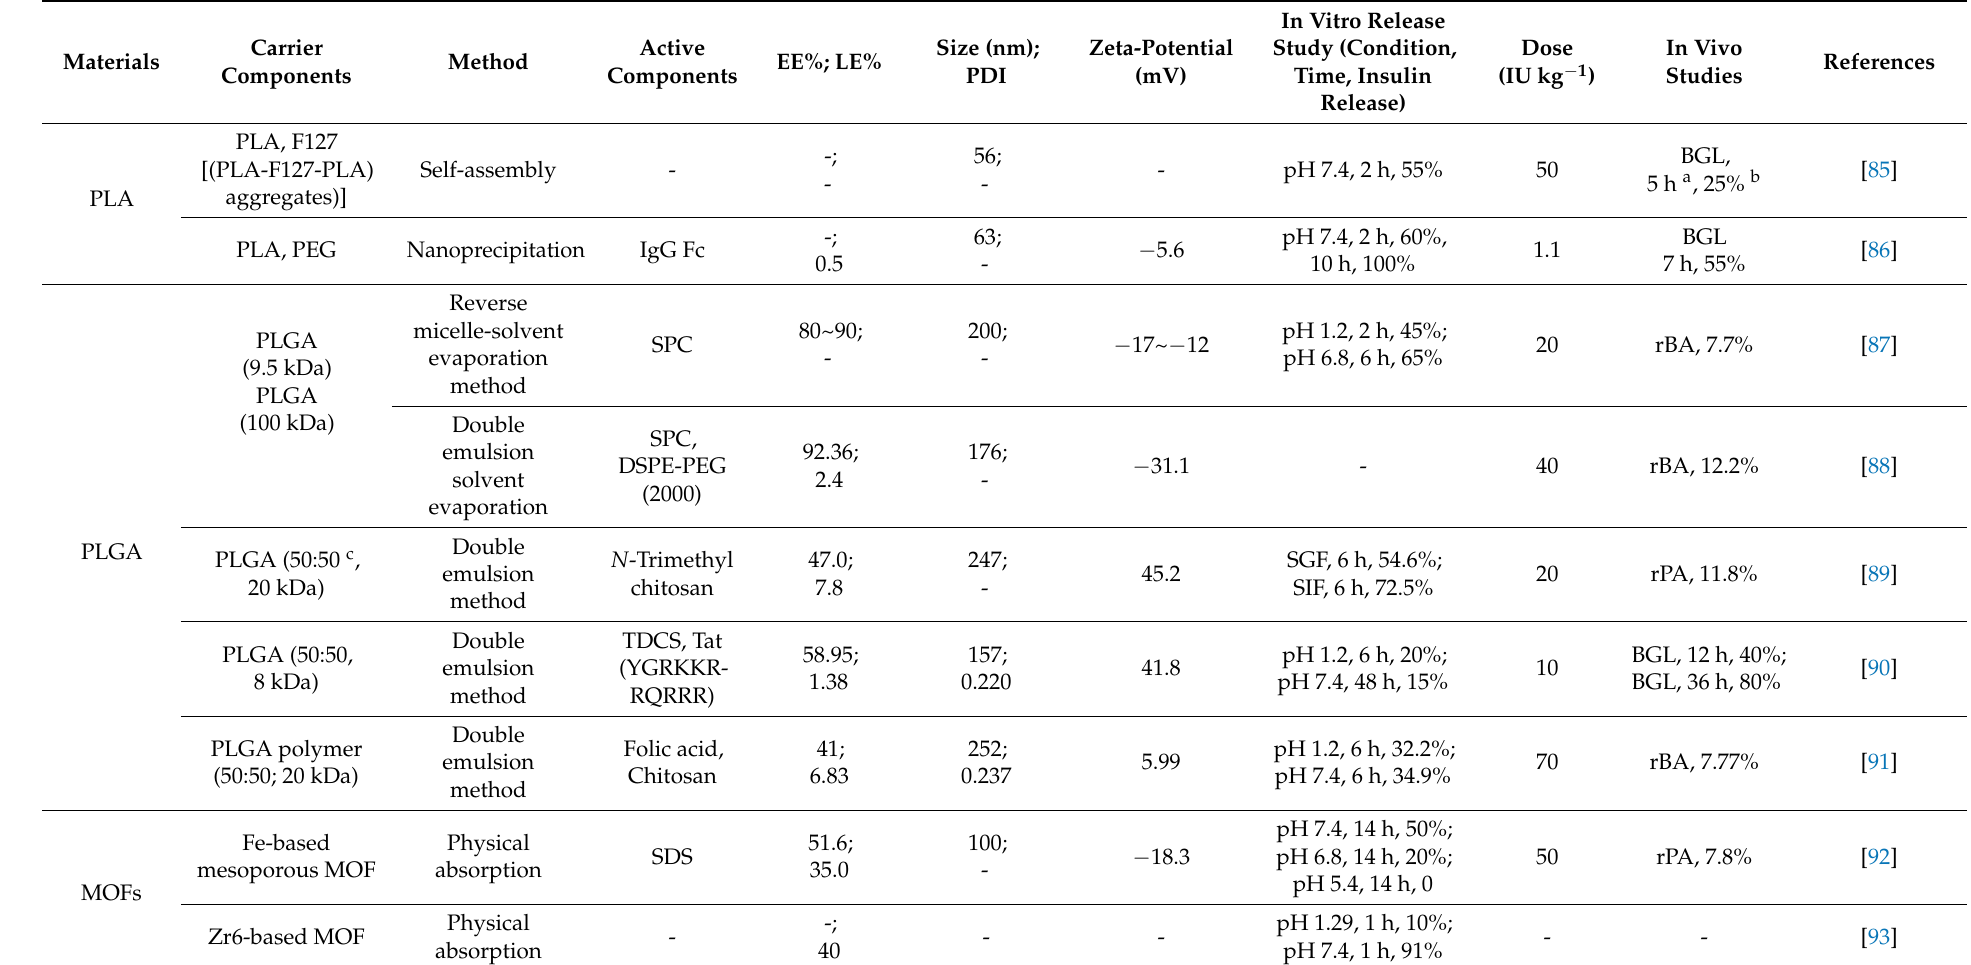
Table 2. Representative materials for construction of oral insulin delivery